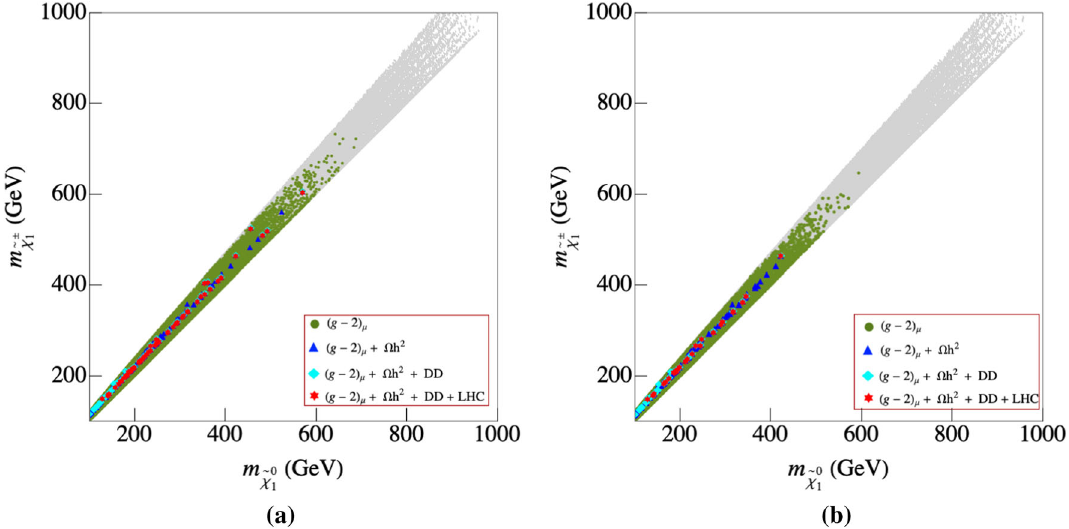
− m plane for the ˜ χ ± -coannihilation scenario (current (left) and anticipated future limits ˜ χ ± 1 1 1